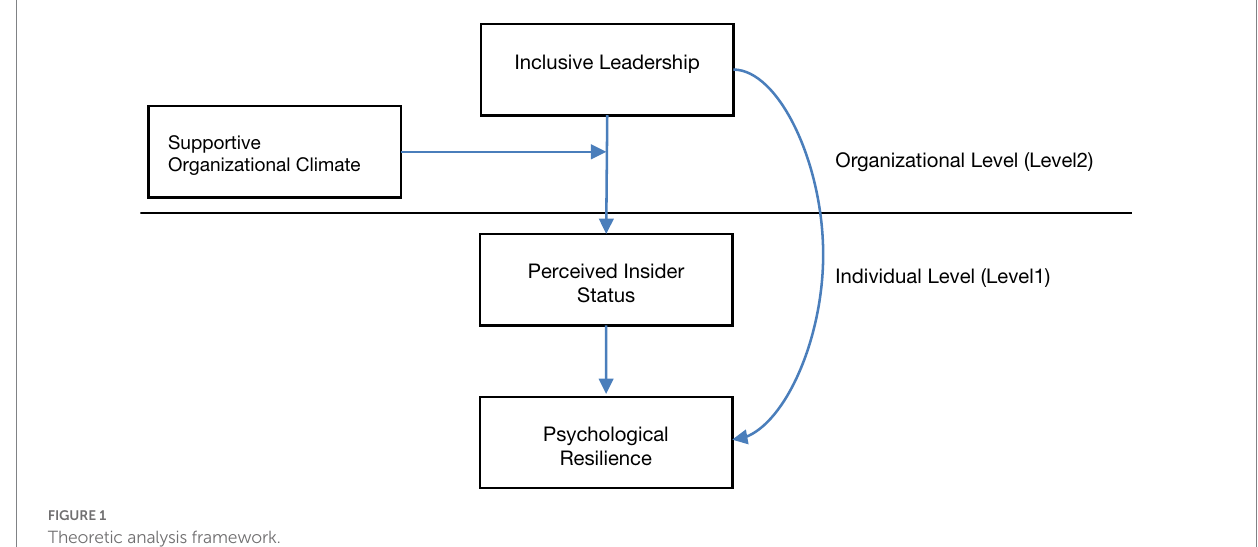
FIGURE 1 Theoretic analysis